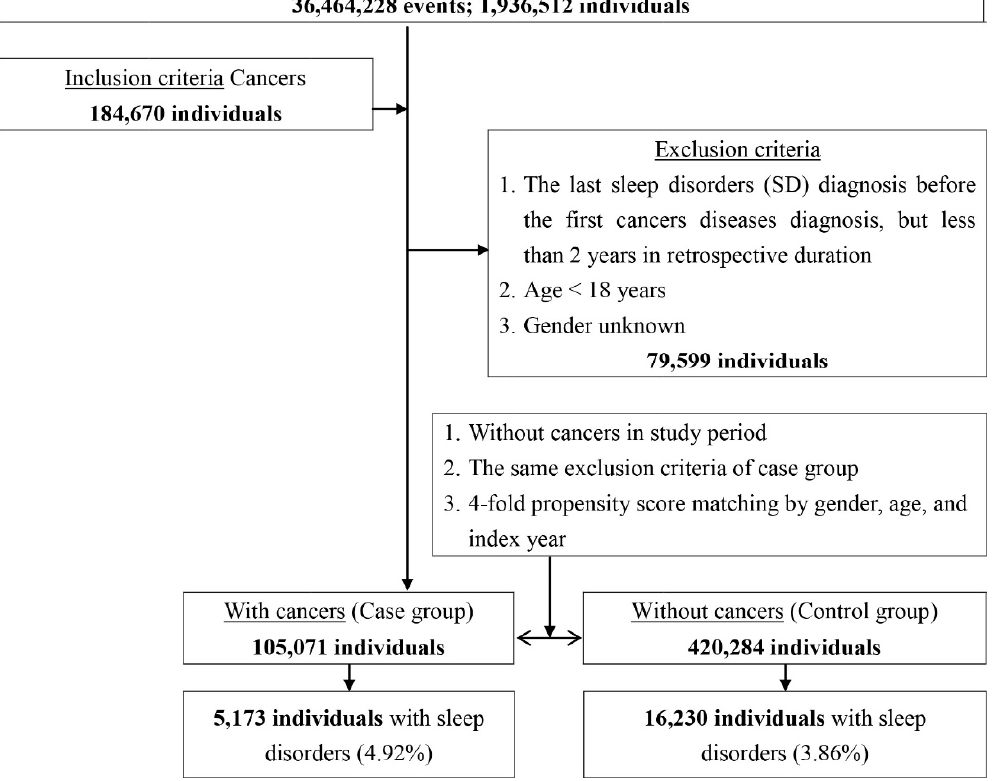
Figure 1. Flowchart of participant selection (nested case-control study) from the National Health Insurance Research Database in Taiwan.